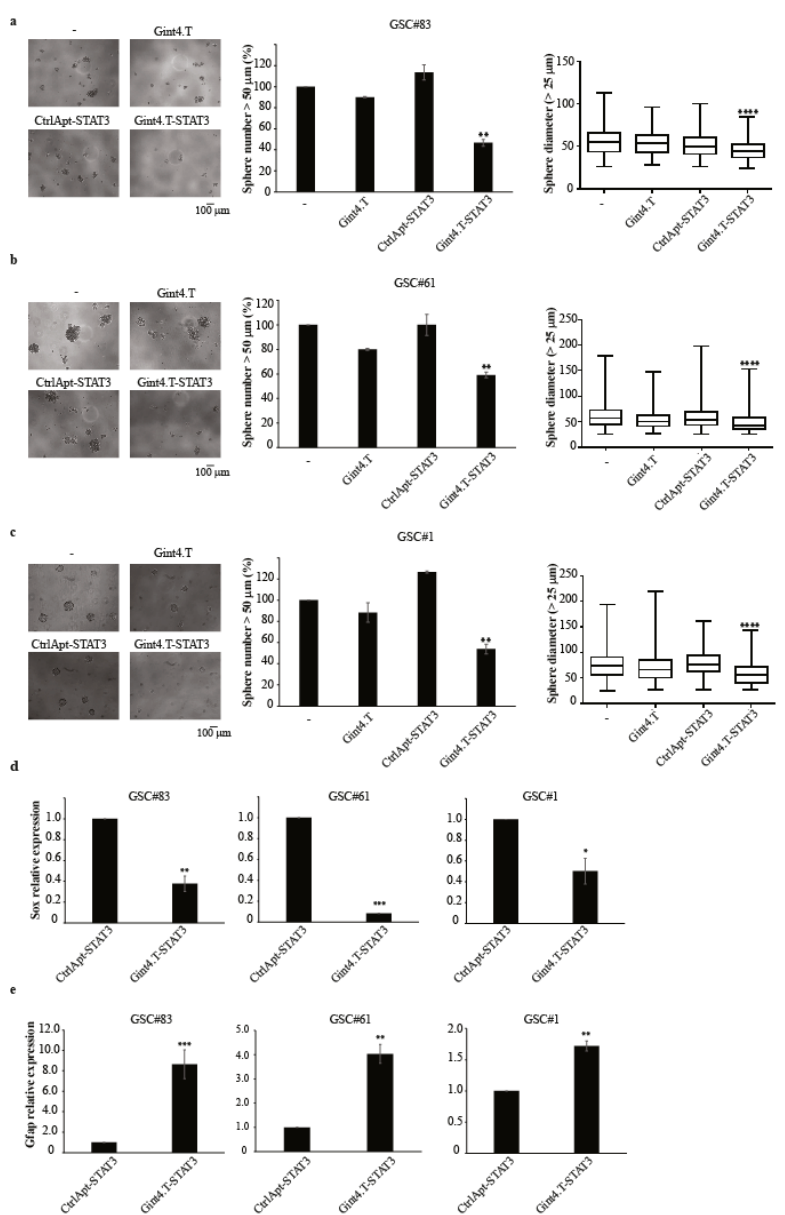
Figure 2. The e ff ect of Gint4.T-STAT3 on primary GSC tumour sphere formation and stemness. ( a – c ) Sphere formation of indicated primary GSC-derived tumour spheres (PDGFR β + ) left untreated ( − ) or treated with Gint4.T, Gint4.T-STAT3, or CtrlApt-STAT3. Left panels are representative micrographs; middle panels are spheres with a diameter > 50 µ m and were counted and expressed as percentage relative to the untreated samples ( − ), set to 100%. Vertical bars depict the mean ± SD; and the right panels are boxplot representations of the diameter measures (spheres with a diameter > 25 µ m). Statistics of the conjugate treatment versus the control sample using one-way ANOVA: **, p < 0.01; ***, p < 0.001 ****; p < 0.0001. ( d ) Levels of Sox were measured by RT-qPCR (left) or immunoblot (right) in primary GSC-derived tumour spheres (PDGFR β + ) treated for 10 days with Gint4.T-STAT3 or control conjugates. Values below the blots indicate quantization relative to the controls, labelled with an asterisk normalized on anti-vinculin signals as a loading control. ( e ) GFAP levels by RT-qPCR after 10 days of GSC treatment with Gint4.T-STAT3 or control conjugates. In ( d , e ), statistics for the conjugate treatment versus the control sample were obtained by Student’s t -tests: *, p < 0.05; **; p < 0.01; ***; p < 0.001. Vertical bars depict the mean ± SD on replicates ( n = 2). Whole blots of Figure 2d are shown in Figure S7.